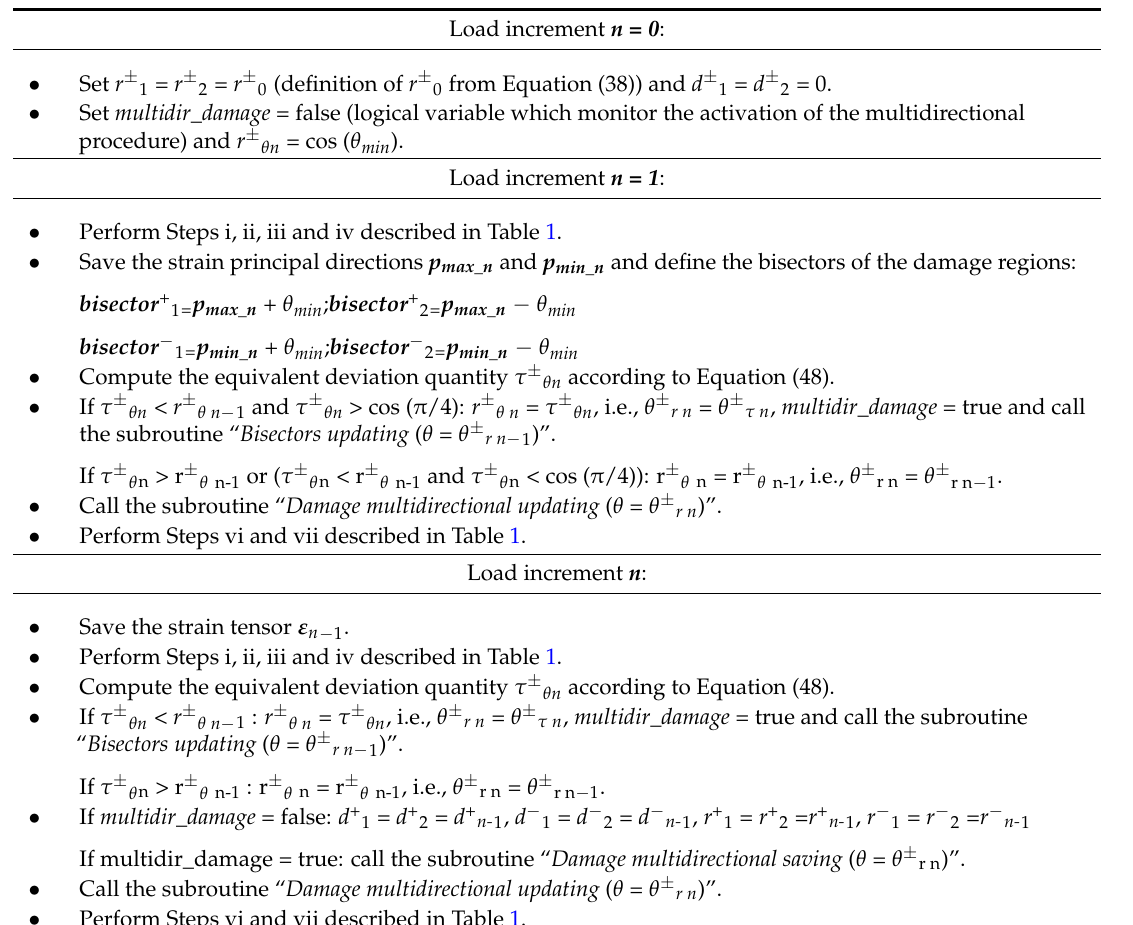
Table 3. Algorithm for the multidirectional d + /d − damage model, Type Load (ii).